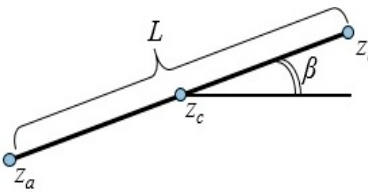
Figure 5. Linear interval sink representing fracture element centered on z c , with end-points z a and z b , total length L , and tilt angle β .